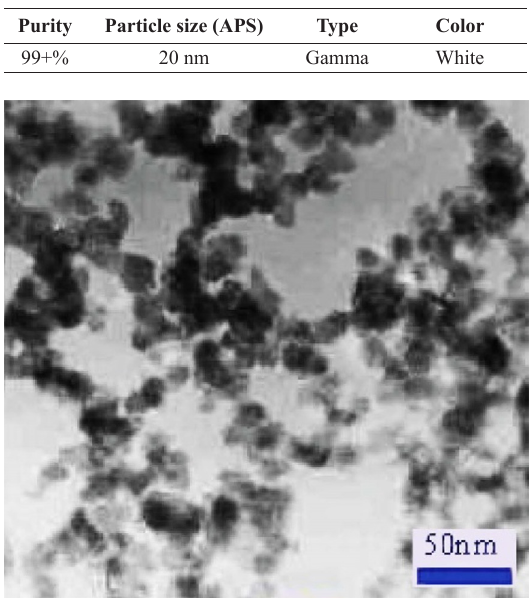
Table 2. Properties of Al